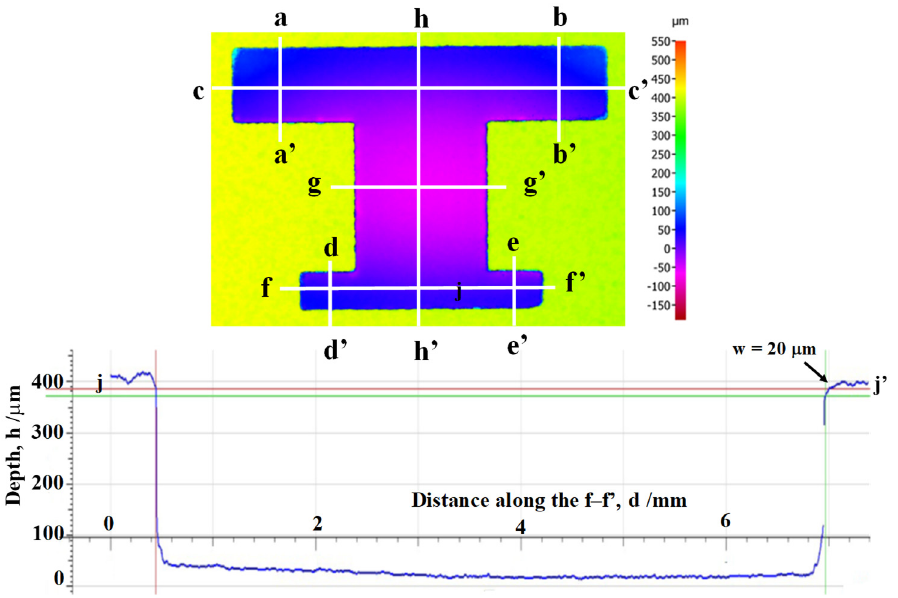
Figure 10. Three-dimensional profile of T-shaped die cavity with its cross-sectional view along the line f–f’.